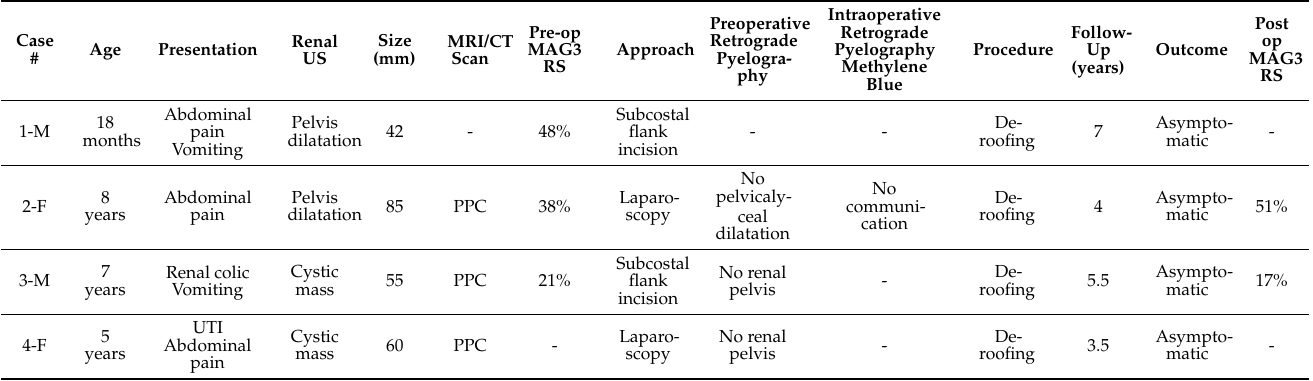
Table 1. Demographics, patients’ characteristics, management and outcomes of symptomatic para- pelvic